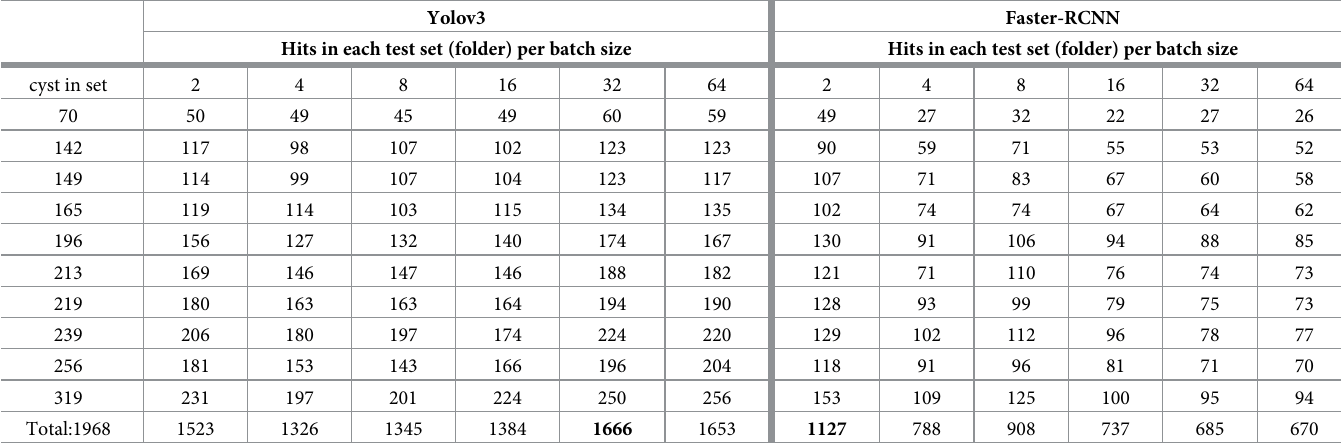
Bold font indicates the best results obtained by each